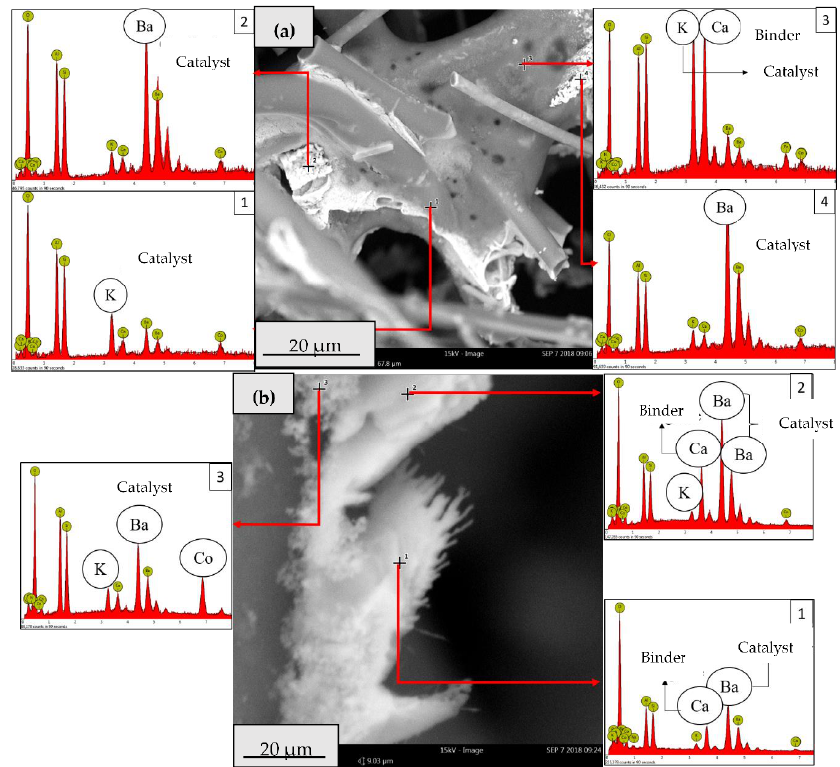
Figure 8. Identification of the deposits found for the sample Co,Ba,K(5)U-I by spot EDX analysis. ( a ) and ( b ) are different analyzed zones of the sample and numbers indicate different points where EDX spectra were acquired.